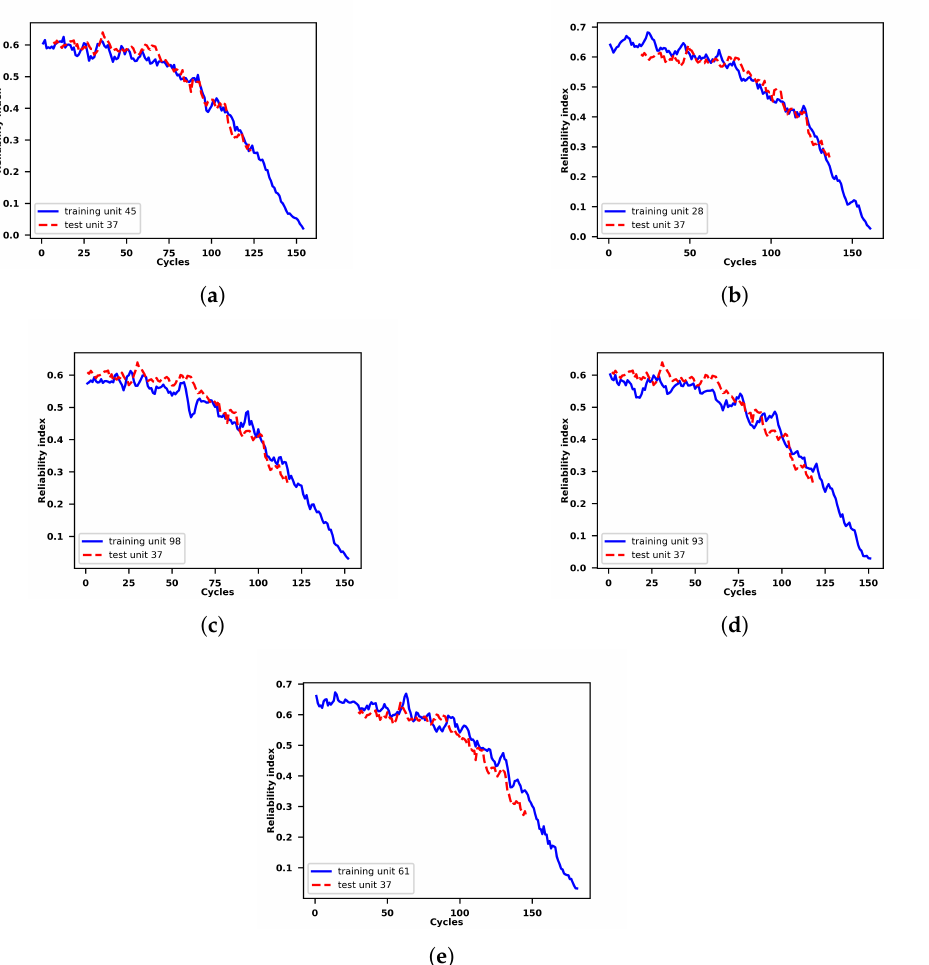
Figure 5. Similarity matching between the incomplete reliability index of the 37th unit in the test set and its five most similar reliability indices of the units in the run-to-failure training set.The similarity decreases with the figure order. ( a ) Incomplete reliability index of the 37th unit in the test set matched with the complete reliability index of the 45th unit in the training set. ( b ) Incomplete reliability index of the 37th unit in the test set matched with the complete reliability index of the 28th unit in the training set. ( c ) Incomplete reliability index of the 37th unit in the test set matched with the complete reliability index of the 98th unit in the training set. ( d ) Incomplete reliability index of the 37th unit in the test set matched with the complete reliability index of the 93rd unit in the training set. ( e ) Incomplete reliability index of the 37th unit in the test set matched with the complete reliability index of the 61st unit in the training